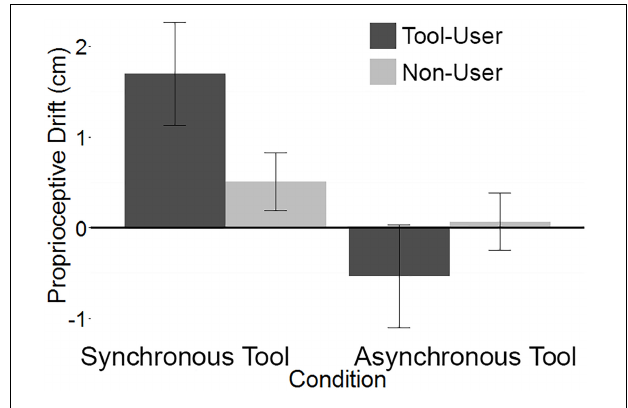
FIGURE 9 | An analysis of the combined Experiments 1 and 2 data. The trending interaction suggests that across experiments, participants who self-report using the tool frequently (Pliers: n = 8, Tweezers n = 35), experience more proprioceptive drift in the synchronous visuo-tactile stimulation condition than do the participants who do not report frequent tool-use (Pliers: n = 58, Tweezers: n = 37). The effect reverses for the asynchronous condition. Error bars represent ± 1